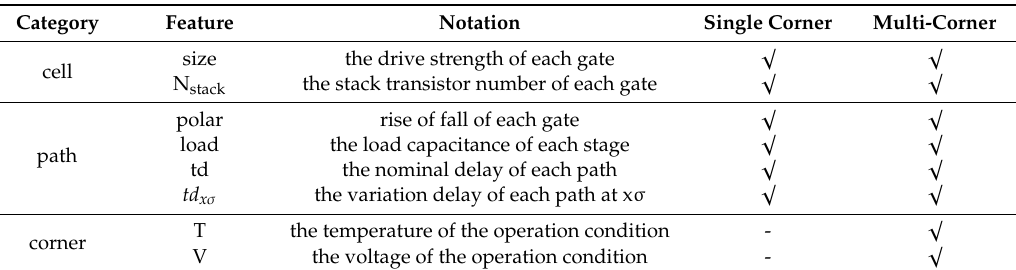
Table 1. Feature selection and